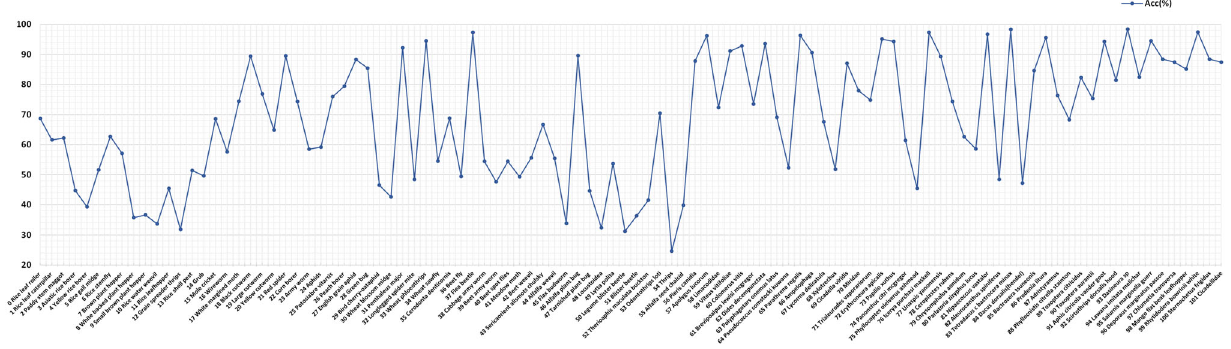
Fig. 9 Accuracy of the proposed method over 102 pest